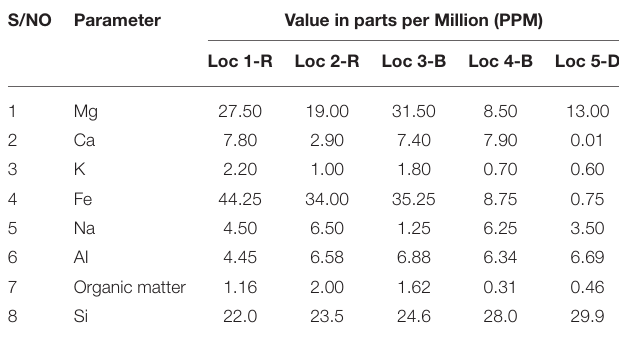
TABLE 5 | Chemical analysis of the active soil (Source: analysis of laboratory